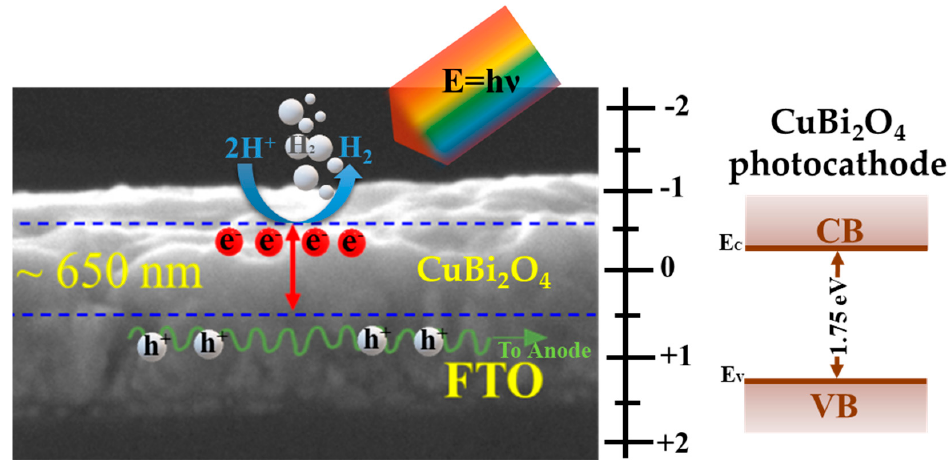
Figure 7. The mechanism and band alignment of CuBi 2 O 4 photocathodes.